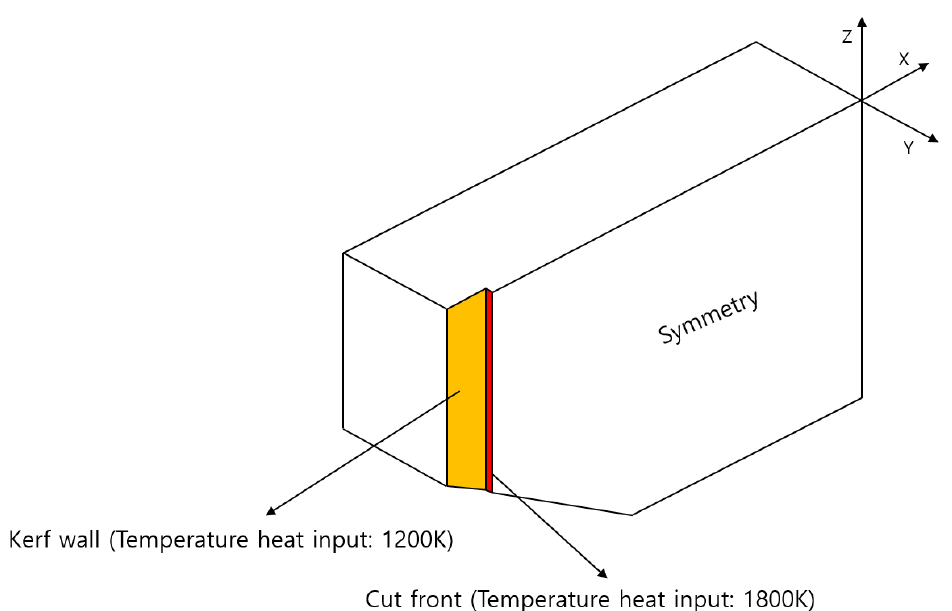
Figure 10. Boundary condition of simulation (symmetry).